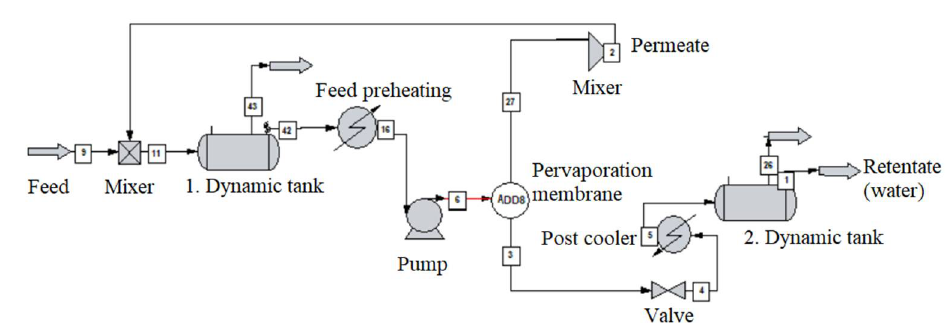
Figure 4. Flowsheet of the recirculating hydrophilic pervaporation method.